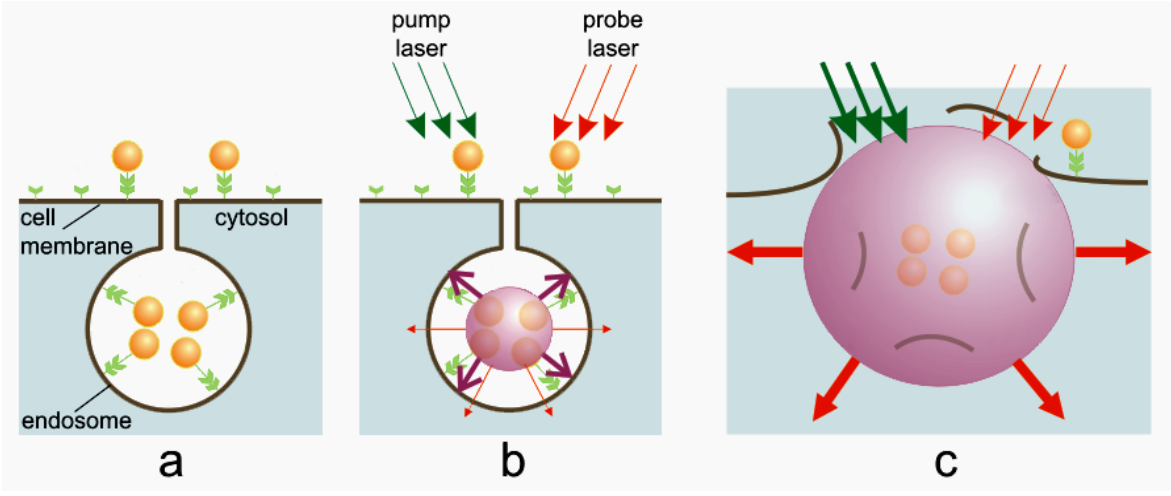
Figure 15. PNB cell theranostics with a multi-stage tunable PNB: ( a ) the cell is targeted with NP-antibody conjugates and intracellular NP clusters are formed through receptor- mediated endocytosis, ( b ) the 1st (diagnostic) PNB provides the data on the cell and allows us to determine the parameters of the next laser pulse, ( c ) the 2nd PNB delivers mechanical impact (cell damage though membrane disruption is shown) and this action is guided through the increased optical scattering (red arrows) of the 2nd PNB; the PNB is tuned by varying the fluence of pump pulse (green arrows) [85].